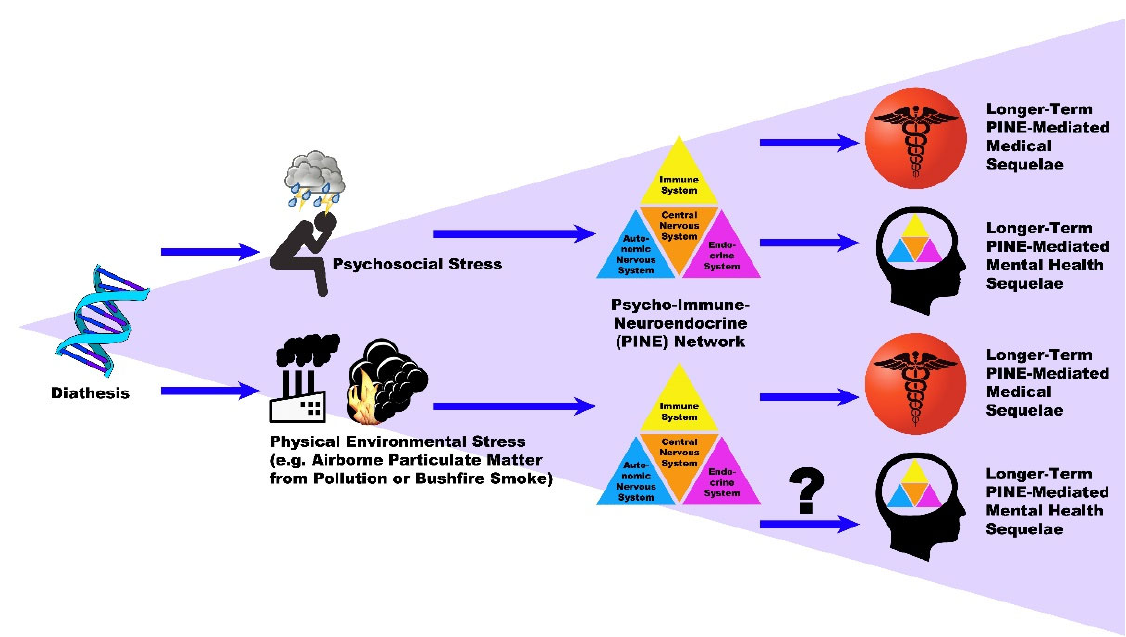
Figure 1. An overview of the potential relationships between diathesis, environmental stressors (e.g., PM), the PINE network, health and potential mental health sequelae.